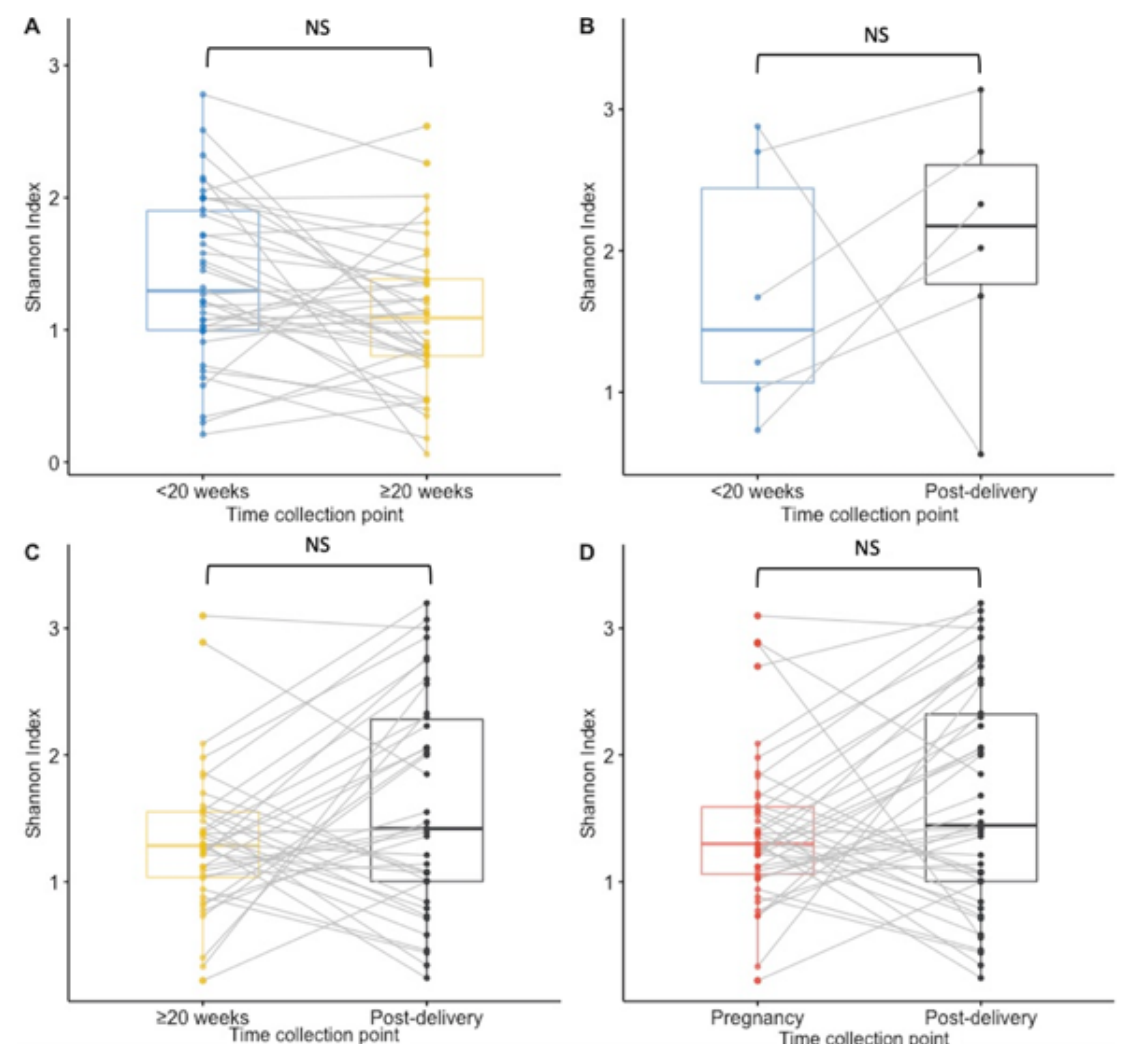
Figure 3. Boxplots for the Shannon diversity index at species level for paired samples. Results of <20 weeks GA pregnancy collection are in blue, ≥ 20 weeks GA pregnancy collection in yellow, post-delivery in black and pregnancy in red. ( A ) The Shannon diversity index was not significantly higher at the ≥ 20 weeks GA pregnancy collection point than at the <20 weeks GA pregnancy collection in matched samples from 38 women. ( B ) There was no significant difference in the Shannon diversity index between the <20 weeks GA pregnancy collection and post-delivery matched samples from 6 women. ( C ) No significant difference was calculated in the Shannon diversity between the ≥ 20 weeks GA pregnancy collection and post-delivery matched samples from 38 women. ( D ) For 42 women who had samples collected at least once during pregnancy and post-delivery, no significant difference in the Shannon diversity index was calculated. NS = non significant.